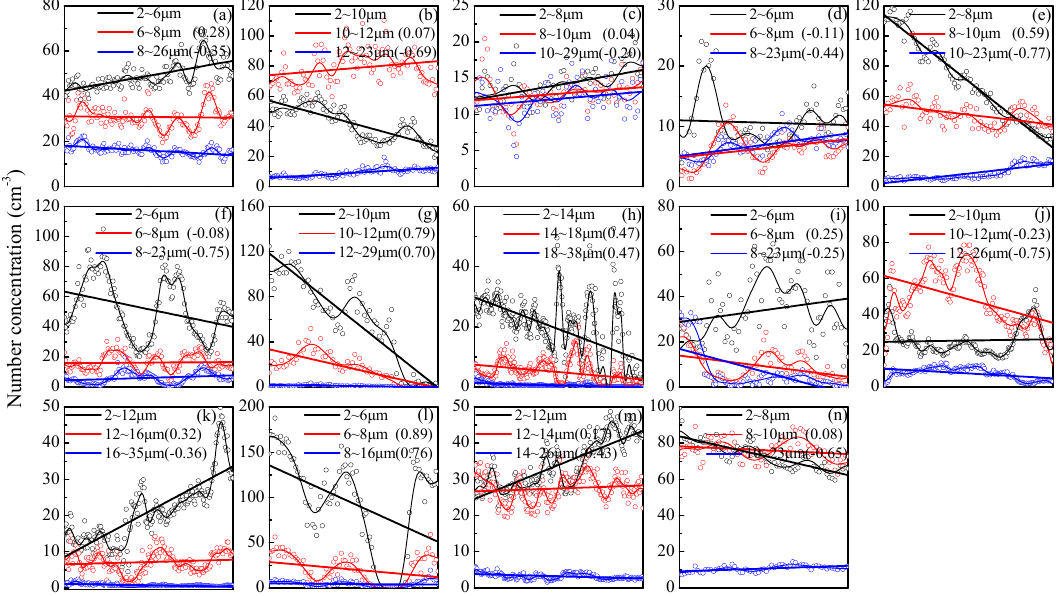
Figure 3. Temporal evolutions and correlation coefficients (in parentheses) of average number concentrations of fog droplets in three categories with similar variation trends. ( a ) Case1; ( b ) case2; ( c ) case3; ( d ) case4; ( e ) case5; ( f ) case6; ( g ) case7; ( h ) case8; ( i ) case9; ( j ) case10; ( k ) case11; ( l ) case12; ( m ) case13; ( n ) case14.